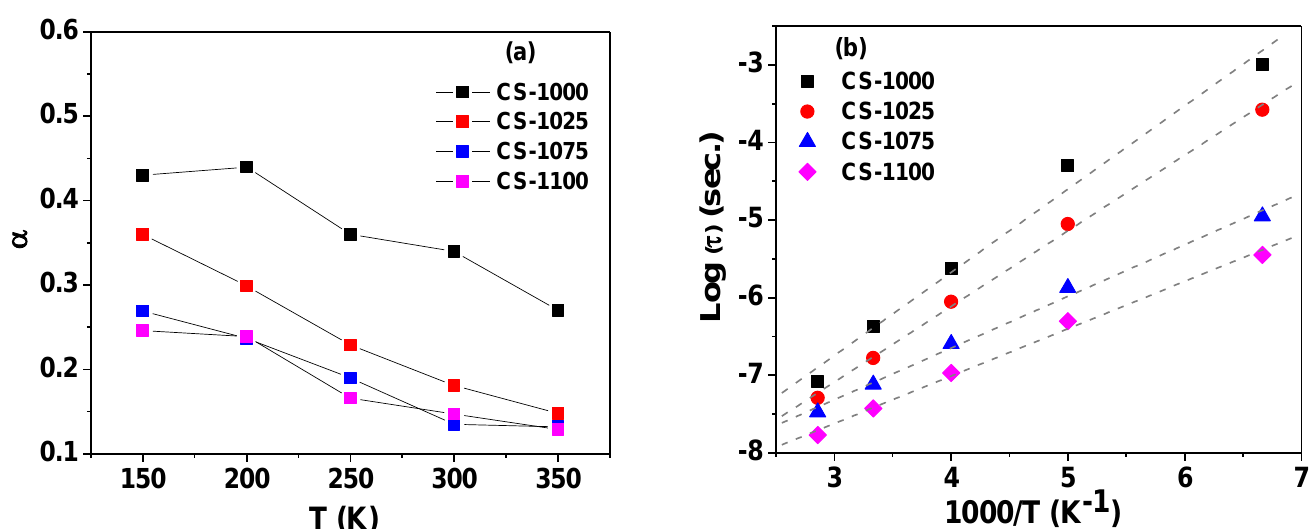
Figure 6. ( a ) The variation of the fitting parameter α with temperature, and ( b ) the Arrhenius plot for relaxation time for the NSCTO ceramic samples.